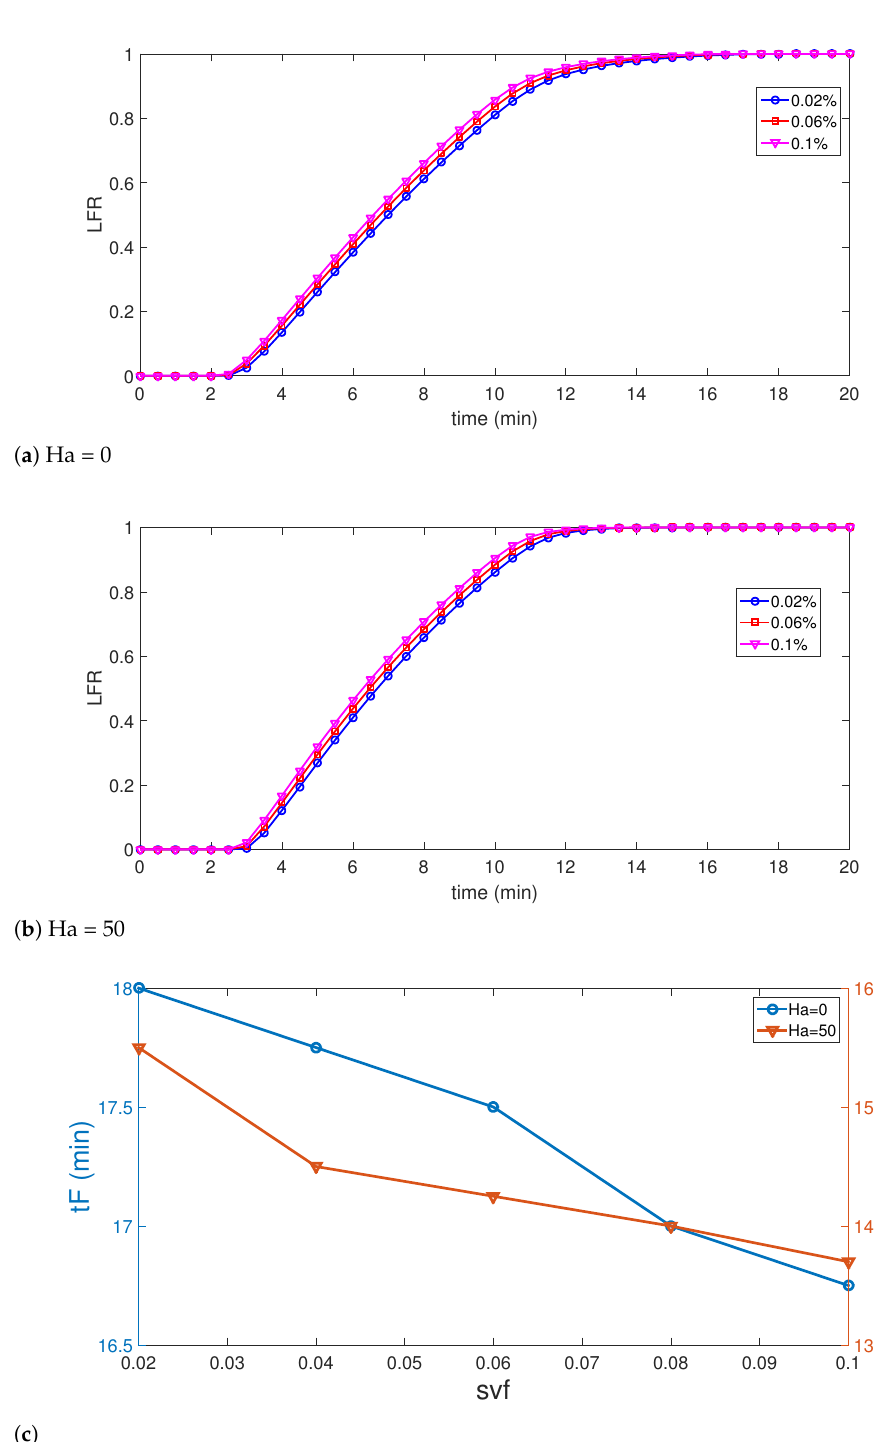
Figure 10. Solid volume fraction (svf) of nanoparticles on the time-dependent variation of LFR at Ha = 0 ( a ), at Ha = 50 ( b ) and on the phase completion time ( c ). In case ( c ), left and right y-axes show results for Ha = 0 and Ha = 50 (constant MF, K = 1.5, M =